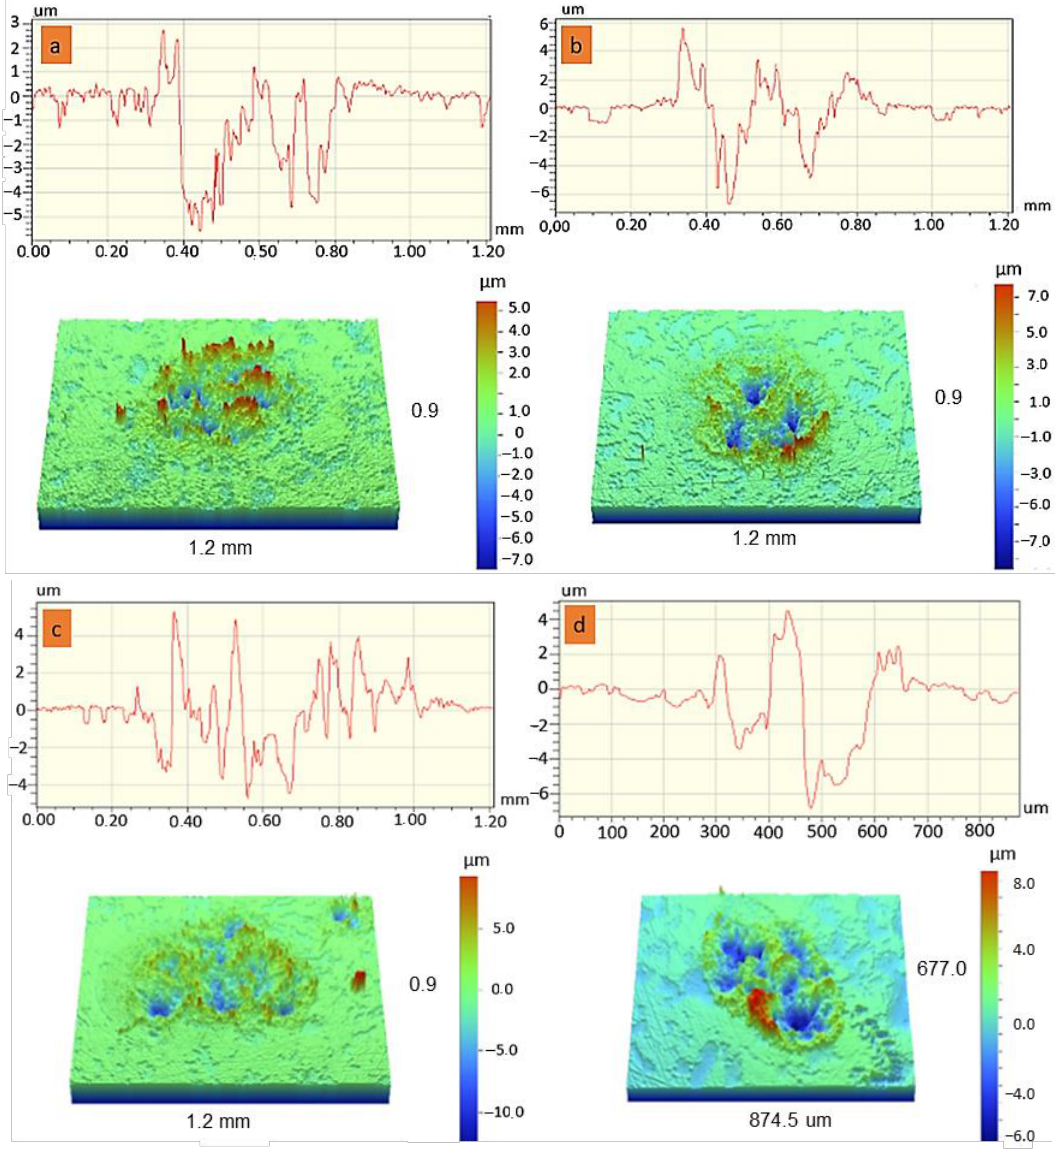
Figure 6. Results of the electroerosion tests for coatings 1 ( a ), 2 ( b ), 3 ( c ), and the Cu-Cr substrate ( d